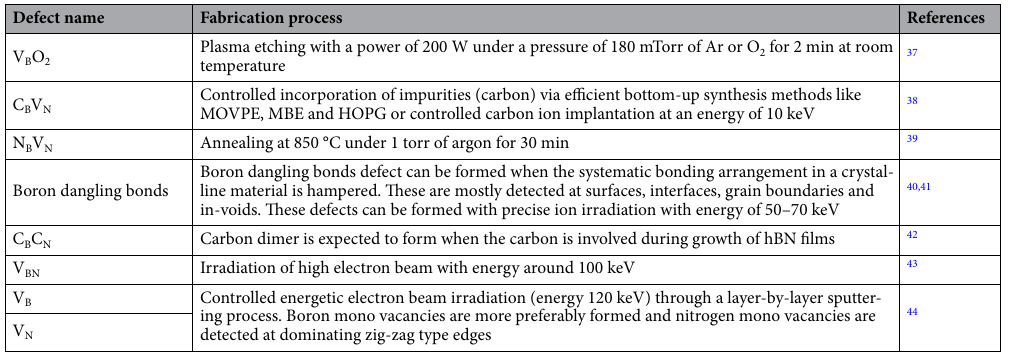
Table 1. Experimental defect fabrication process and corresponding references (Published literature).